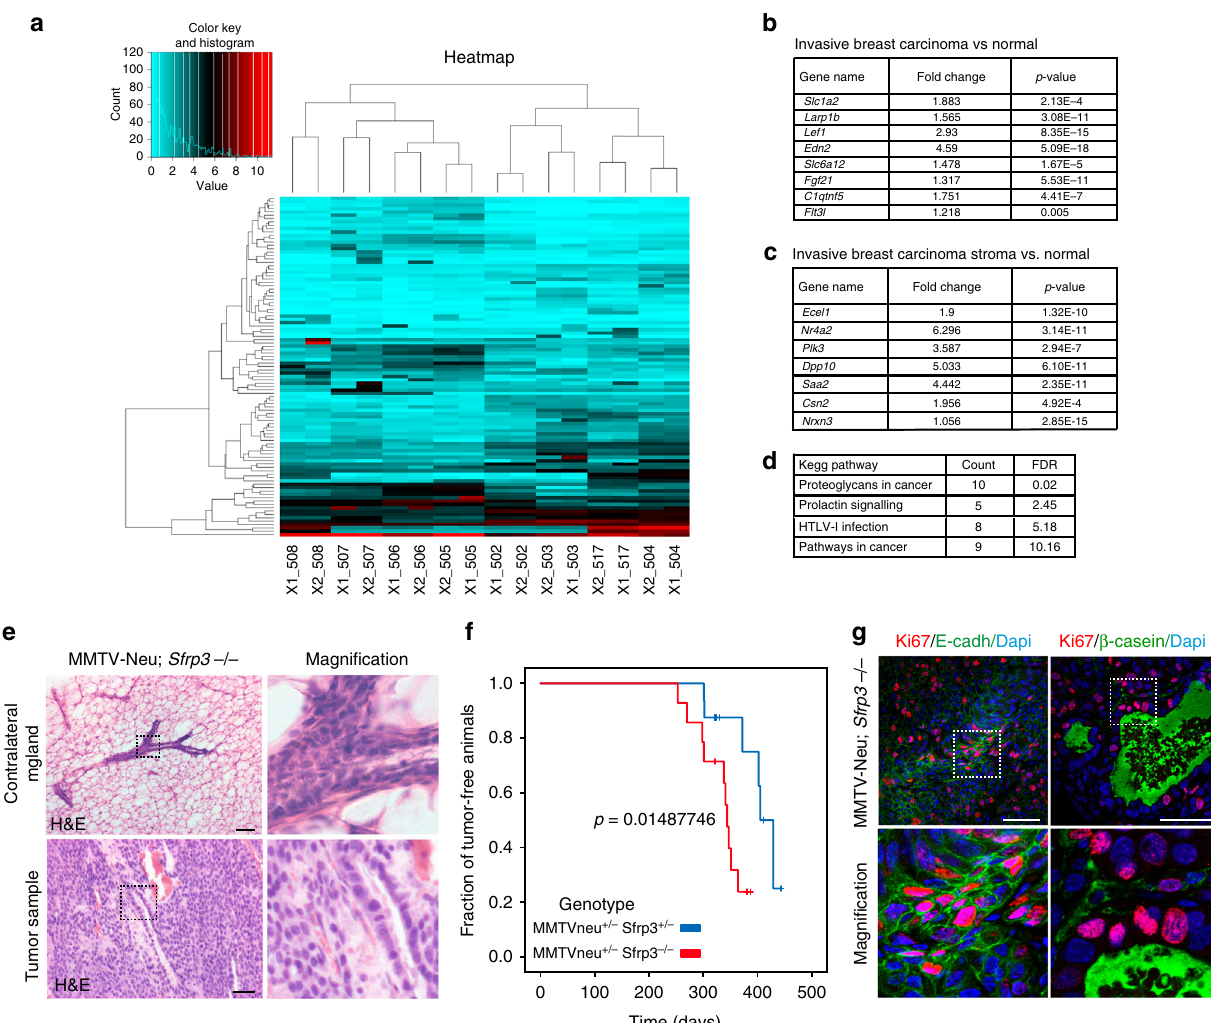
Fig. 7 Sfrp3 − / − epithelial cells show a cancer-associated pro fi le. a Clustered heatmap of the top 100 DEGs between FACS-sorted Sfrp3 + / + and Sfrp3 − / − epithelial cells. Red, increased expression; turquoise, reduced expression. The names of the samples are shown below the heatmap. Sfrp3 − / − samples: 508, 507, 506, 505. Sfrp3 + / + samples: 502, 503, 517, 504. Two technical replicates for each sample library were sequenced (X1/X2). b Oncomine analysis of the top 100 DEGs. List of genes interrogated in the Cancer Genome Atlas (TCGA) dataset and found to be uregulated ( p ≤ 0.005) in invasive breast carcinoma compared to control sample. c Oncomine analysis of the top 100 DEGs. List of genes interrogated in the Finak dataset and found to be uregulated ( p ≤ 0.005) in the stroma of invasive breast carcinoma compared to control sample. d KEGG pathway analysis of 102 DEGs. The top 4 pathways with a false discovery rate (FDR) ≤ 10% are shown. e Representative images of HE-stained mammary glands from MMTV-Neu; Sfrp3 − / − virgin females presenting tumours (bottom panels). Upper panels show the contralateral mammary gland used as a control, that present fi lled ducts. Scale bar: 50 µ m. f Quantitative analysis of the fraction of tumour-free animals in a MMTV-Neu + / − ; Sfrp3 − / − genotype (red line) compared to controls ( MMTV-Neu + / − ; Sfrp3 + / − ). p = 0.01487746. g Representative images of immuno fl uorescence staining for Ki67 (red), E-cadherin (green), nuclei (blue) (left panels); and Ki67 (red), β -casein (green), nuclei (blue) (right panels), on MMTV-Neu + / − ; Sfrp3 − / − virgin females presenting tumours. White square denote area magni fi ed on bottom panels. Scale bar: 50 µ m. Images in e , g are representative of at least 4 MG sections analysed in 4 different experiments. See also Tables S1, S2, S3, S4. Source data are provided as a Source Data fi le